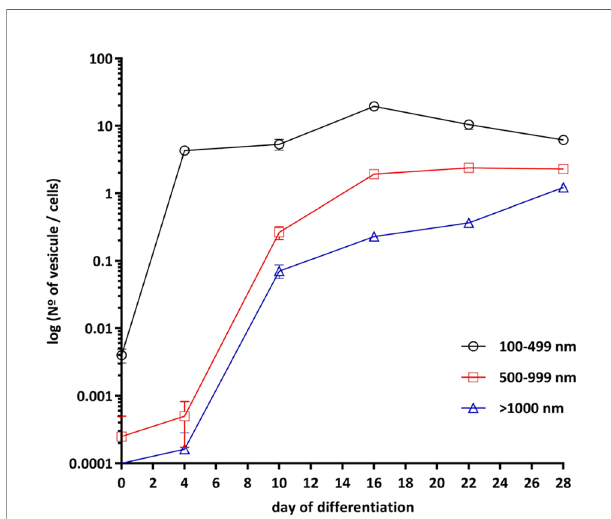
FIGURE 3 | Adipogenic differentiation of SGBS cells. SGBS cells differentiation was according to differentiation protocol. Cells imaging was taken at days 0, 4, 10, 16, 22 and 28 of differentiation. The presence of lipid droplets was assessed at magni fi cation of 20×. Analysis of the different size of lipid droplets (100 – 499, 500 – 999 and >1000 nm) was perform with by ImageJ. All data are presented as mean ± SEM after three independent